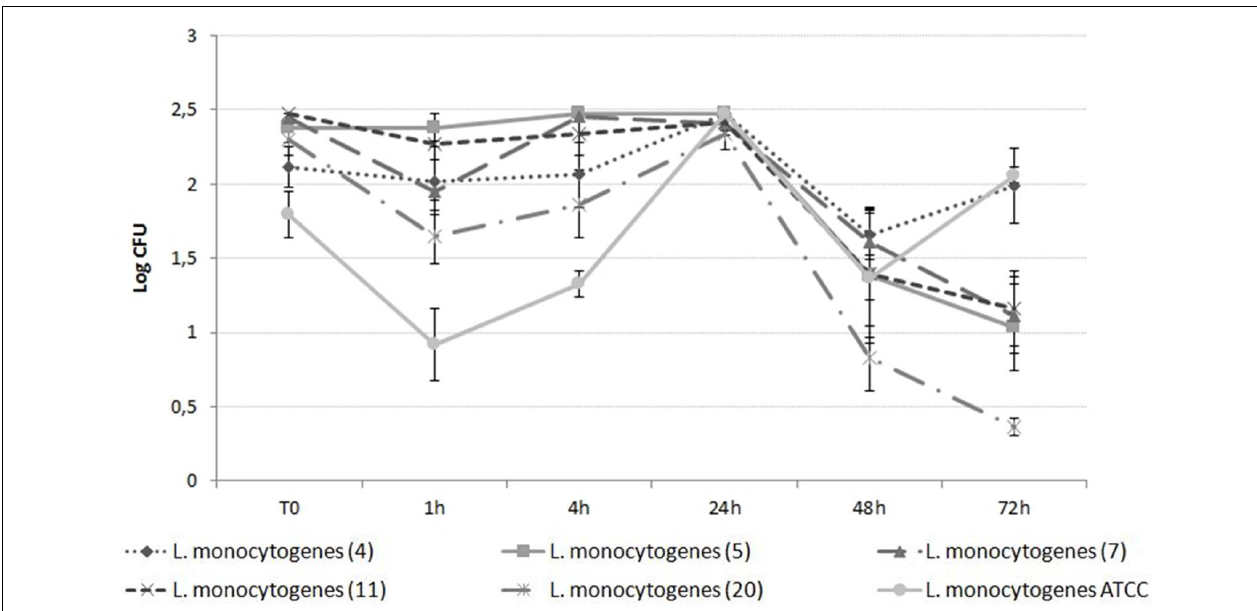
FIGURE 3 | Growth curve of L. monocytogenes in the presence of 300 ppm